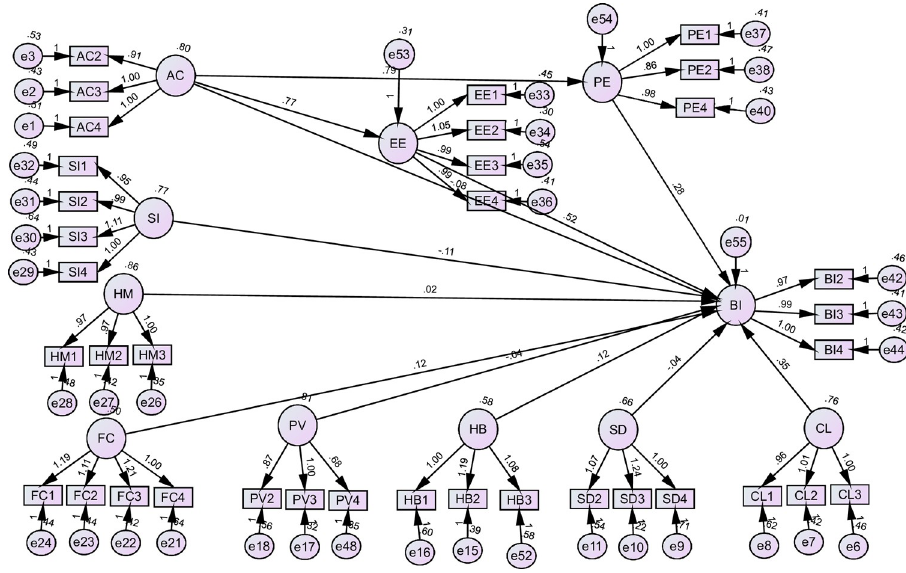
Fig 4. SEM analysis for